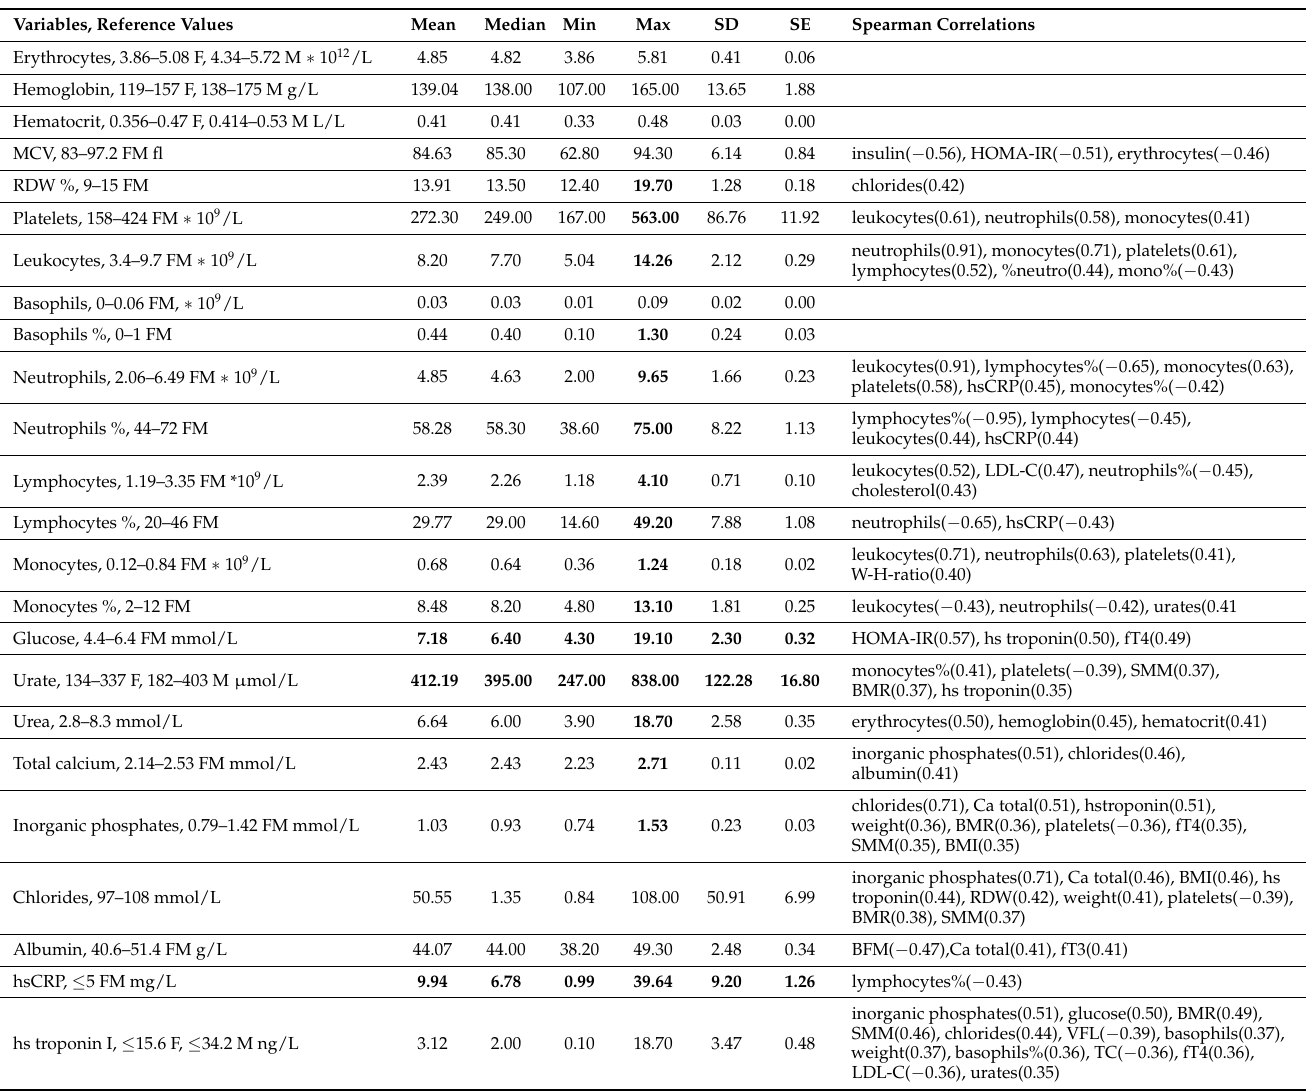
Table 2. Biochemical parameters measured in the entire group (n = 53) with BMI ≥ 35 kg m − 2 with Spearman